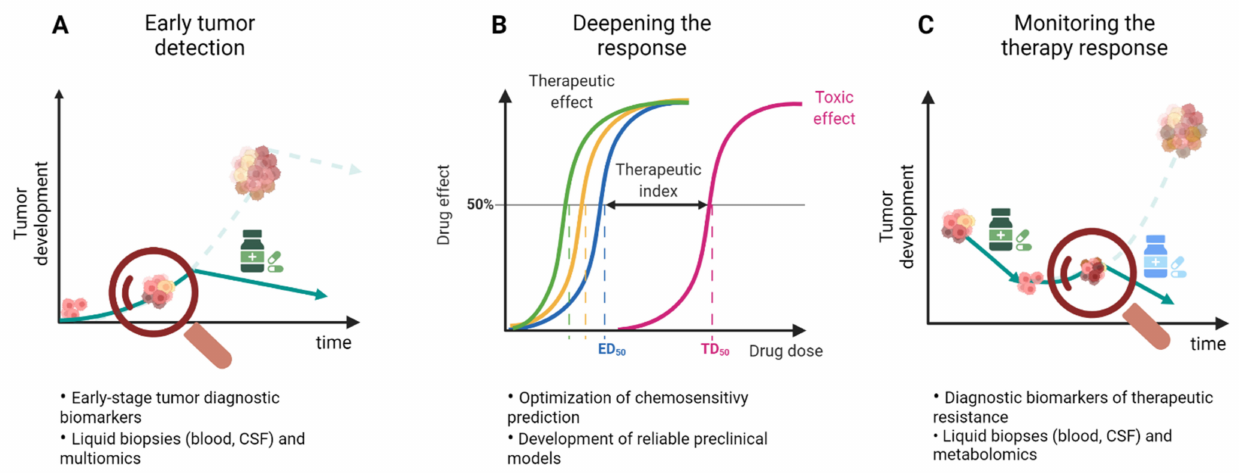
Figure 3. Three strategies to approach drug resistance in GBM. ( A ) Detection of the tumor at early stages would allow a more effective eradication of the tumor and prevention of drug